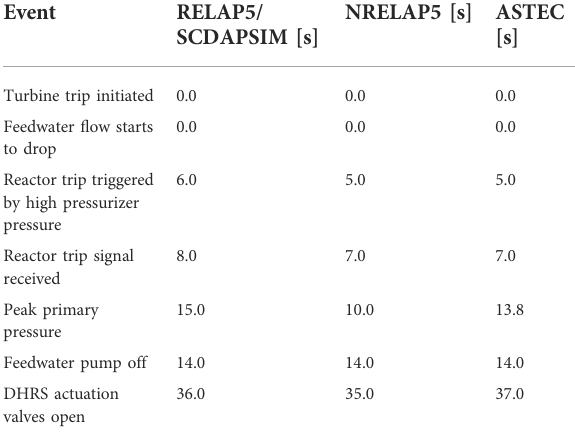
TABLE 7 Timing of events in the turbine trip transient simulated by RELAP5/SCDAPSIM (Skolik et al., 2018b), NRELAP5 (NuScale Power LLC 2020f) and